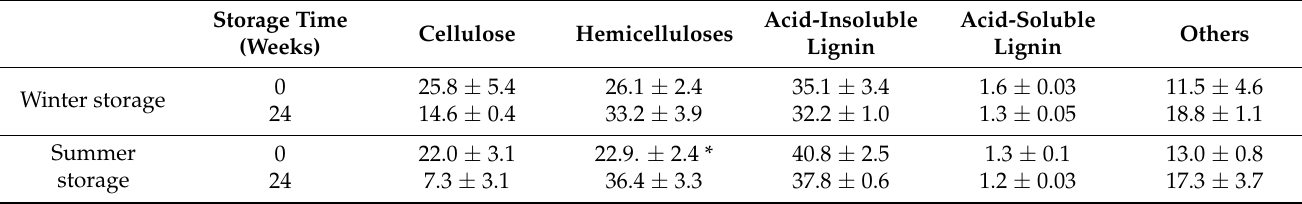
Table 6. Change in chemical composition of extractives-free spruce bark during storage (% of dry matter). Storage